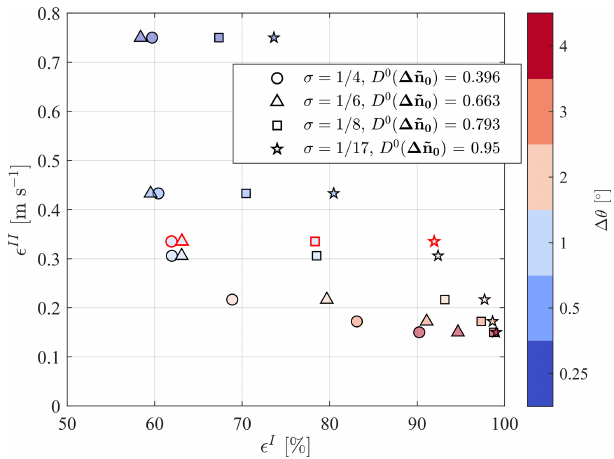
Figure 5. Pareto front for the design of the optimal lidar scan for the reconstruction of the wakes generated by wind turbines B16–B19. The markers highlighted in red correspond to the respective param- eters obtained from the actual lidar data after the quality control